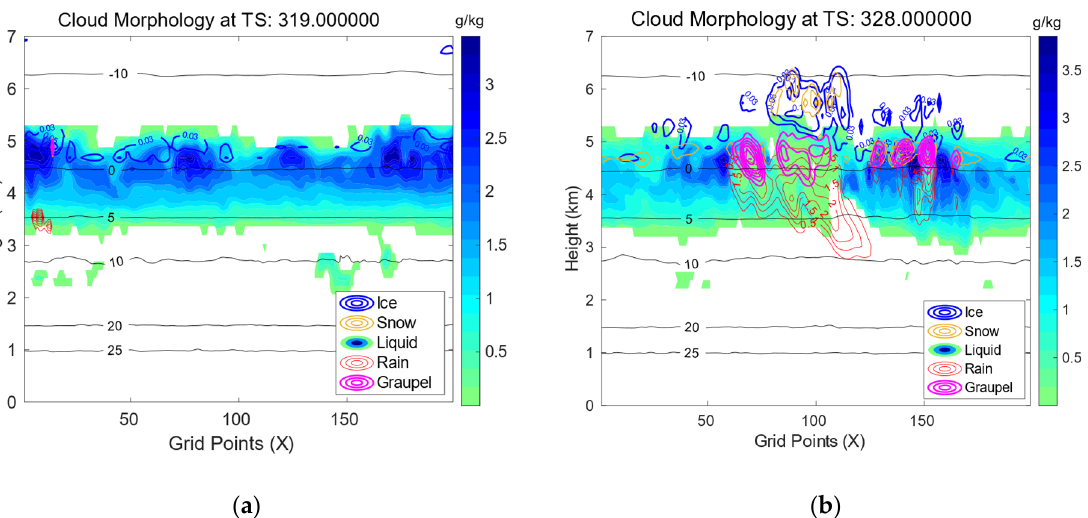
Figure 4. Modelled cloud morphology over Chennai obtained from the LES model. ( a ) Hydrometeor